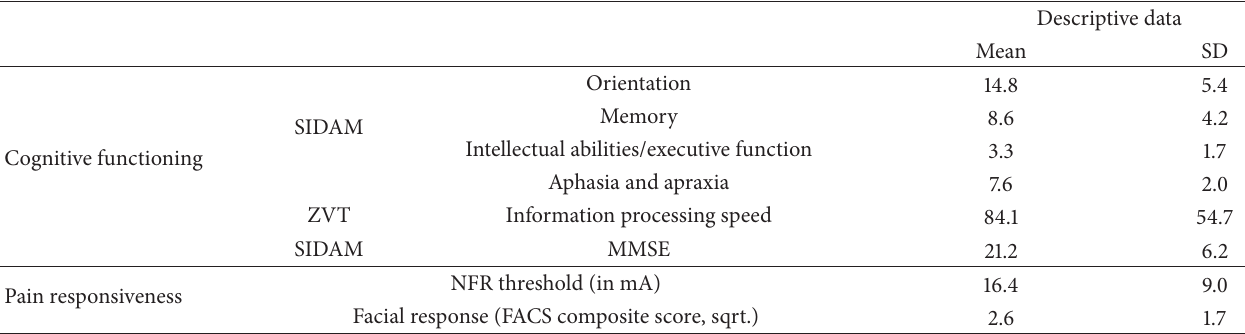
Table 2: Descriptive data of the cognitive performance within the different domains of cognitive functioning assessed and of pain